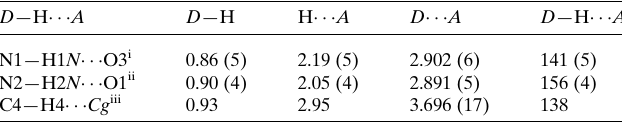
Table 1 Hydrogen-bond geometry (A˚ , (cid:2) ). Cg is the centroid of the C20–C25 ring.